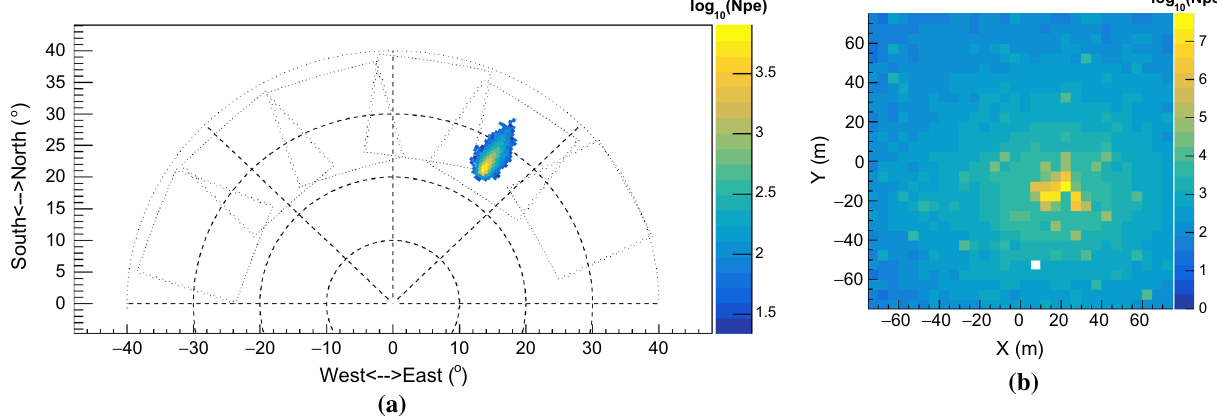
Fig. 19 A coincidence event as seen by WFCTA ( a ) and by the first WCDA pond ( b ). The white pixel in panel ( b ) is a dead channel. The shower geometry is reconstructed by WCDA. The zenith and azimuth angle are about 24.0 ◦ and 57.0 ◦ , respectively. The shower core position